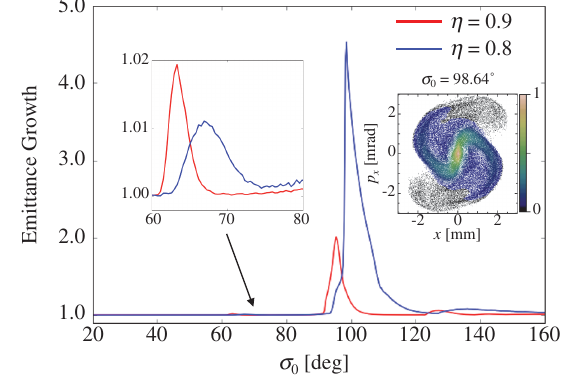
FIG. 2. W ARP simulation results assuming the symmetric FODO lattice with ξ ¼ 0 . 5 and ζ ¼ 1 . The external focusing potential is completely linear (no nonlinear error fields). The growth rate of average transverse rms emittance after 100 FODO periods is plotted as a function of the bare betatron phase advance σ 0 . We have initially taken a 1 MeV proton beam in the thermal equilibrium state well matched to the FODO lattice. Two different initial tune depressions are considered here; namely, η ¼ 0 . 8 (blue) and 0.9 (red). The final phase-space profile at σ 0 ¼ 98 . 64 ° in the case of η ¼ 0 . 8 is displayed which supports our expectation that the linear resonance ( m ¼ 2 ) is responsible for the large emittance growth. The color scale attached represents the normalized particle density. The 90% emittance assumed at the entrance of the transport channel is 0 . 98 π mm · mrad. A different choice of the input emittance only changes the scales of the ( x; p x )-axes, keeping the overall phase-space configura- tion. The growth rate is also unaffected as long as η is